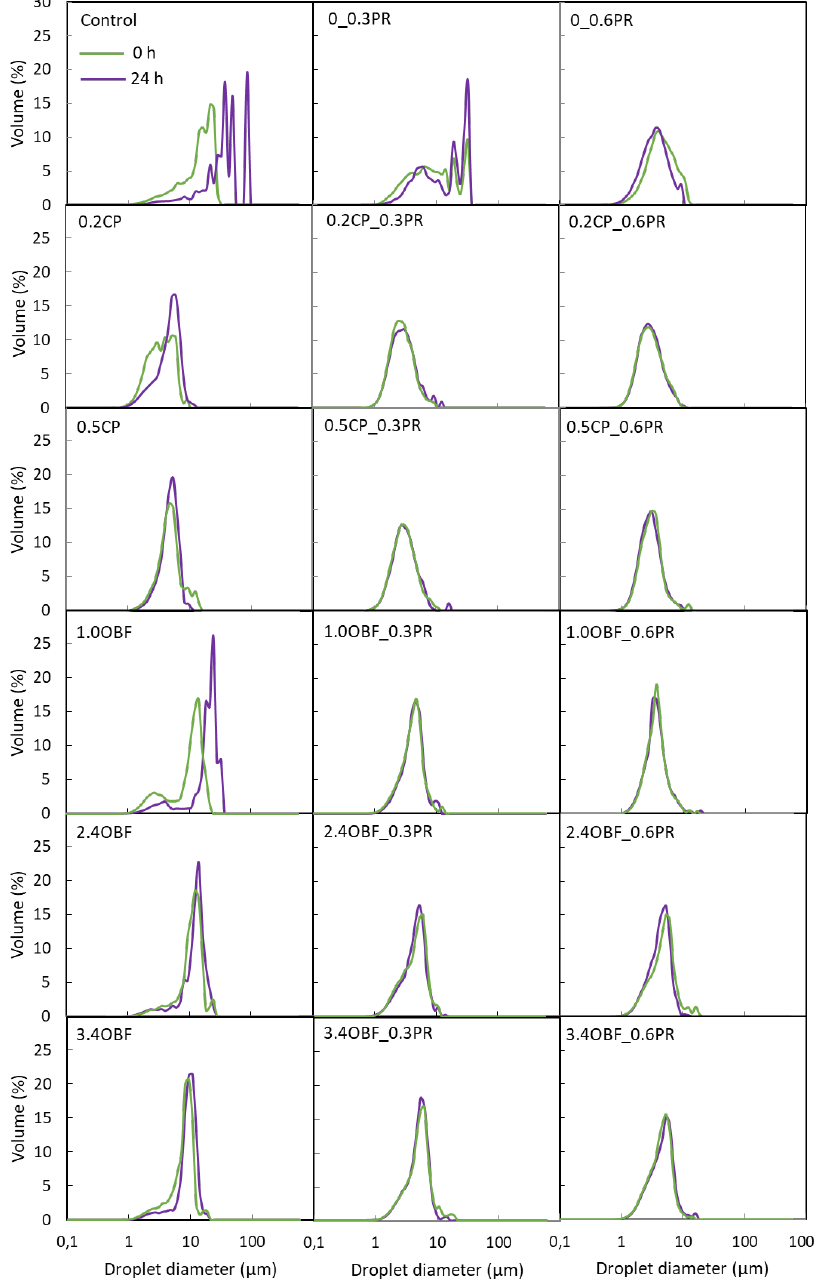
Figure 2. Droplet size distribution of oil-in-water emulsions obtained immediately after their preparation (0 h) and after 24 h without any source of pectins or proteins (control), containing purified commercial pectins (0.2CP and 0.5CP corresponding to 0.2 and 0.5% w / w , respectively) or an orange by-product flour (1.0OBF, 2.4OBF, and 3.4OBF corresponding to 0.95, 2.38, and 3.40% w / w , respectively) combined with proteins (0.3PR and 0.6PR corresponding to 0.3 and 0.6% w / w , respectively) or without them (0PR).